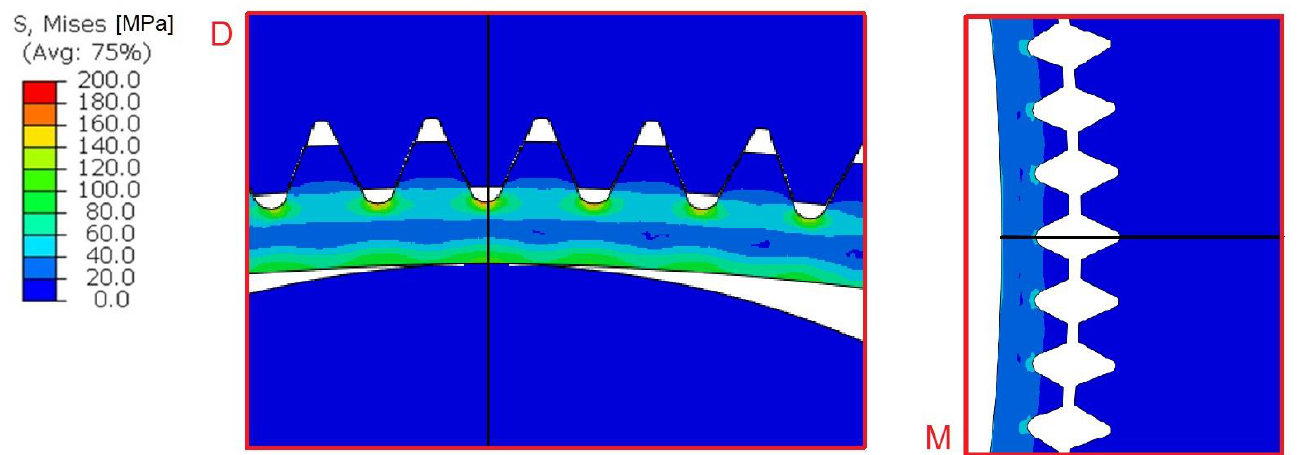
Figure 10. Stress distribution on the model of harmonic hermetic drive with the double-roller gen- erator.